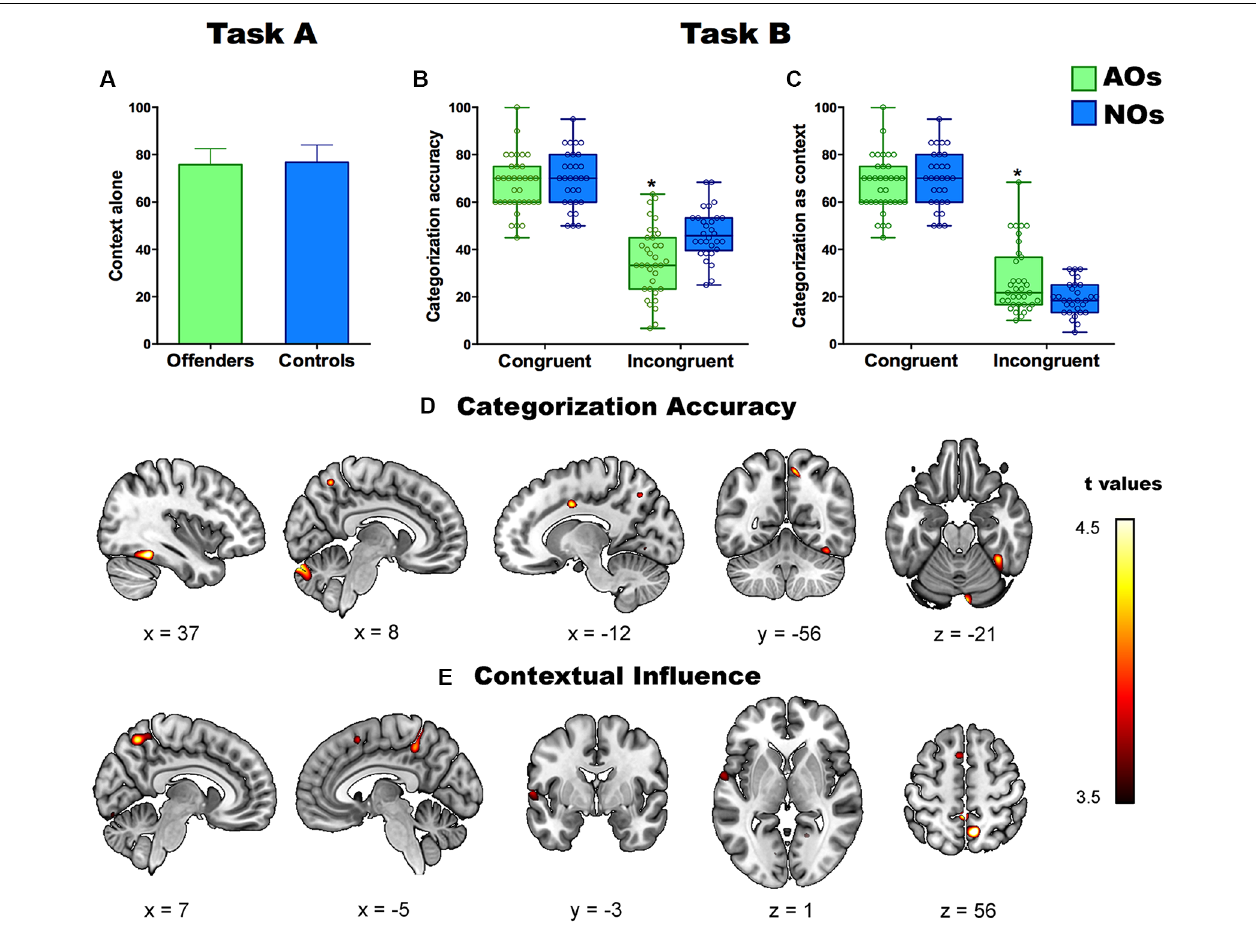
FIGURE 2 | Panel (A) shows percentage of correct labeling of emotions in Task A (context alone) in adolescents offenders (AOs) and non-offenders (NOs). Panels (B,C) show the performance in the two contextual indices (categorization accuracy and contextual influence) of Task B. Asterisks depict significant differences between groups. Panels (D,E) show the significant correlations between gray matter (GM) volume and performance in categorization accuracy (D) and contextual influence (E) in all subjects. Colored brain areas depict significant brain-behavior correlations at p < 0.001 (uncorrected). ∗ Indicates a statistically significant